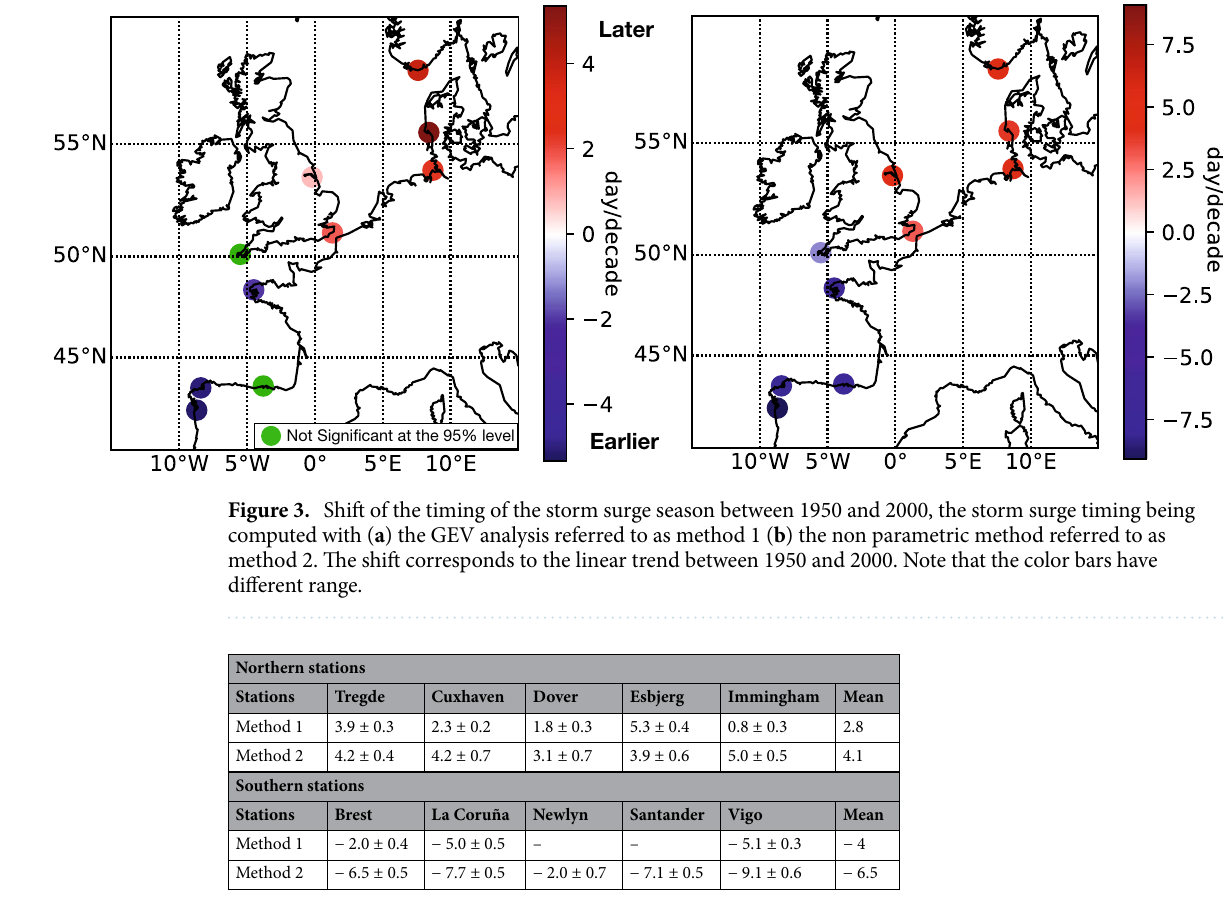
Table 1. Linear trends (day/decade) in the timing of the storm surge season at each station, computed with two different methods, the GEV analysis (method 1) and the non parametric statistics (method 2) between 1950 and 2000. Non significant trends are marked with dash. Standard errors are 1 σ